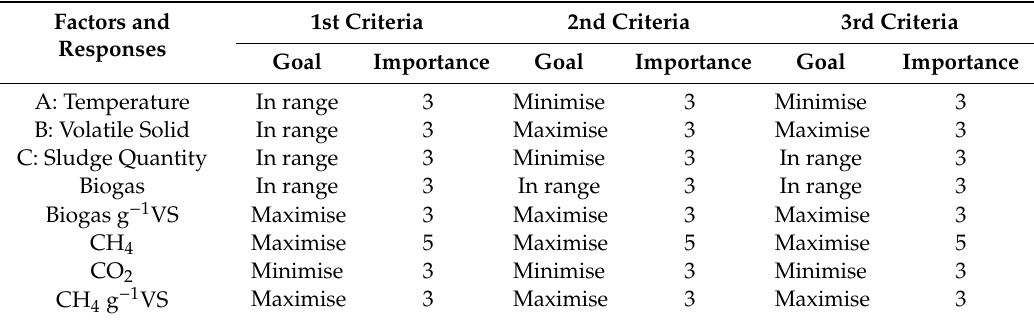
Table 11. The optimisation criterion and